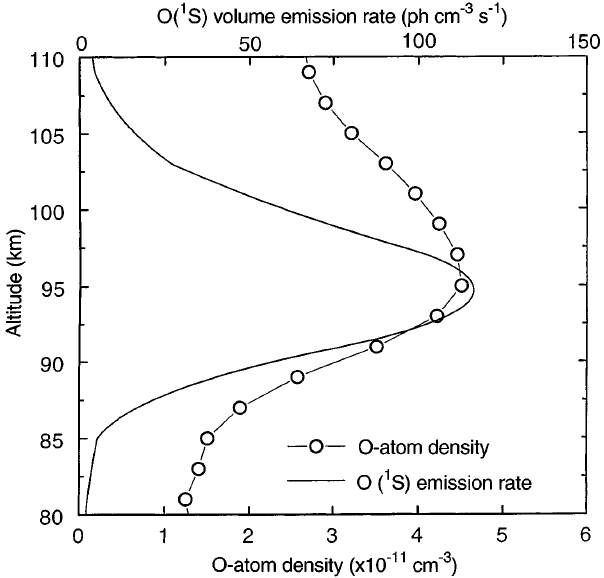
Fig. 1. A typical WINDII greenline volume emission profile ( solid line ) and the atomic oxygen densities derived from it as described in the text ( open circles ). This greenline profile was obtained by averaging all of the profiles within the local solar time/latitude bin 21–22 h/30 (cid:176) S-24 (cid:176) S